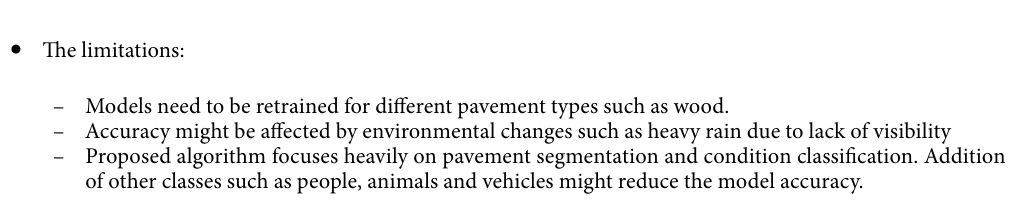
Figure 37. Unet segmentation results: pavement with water